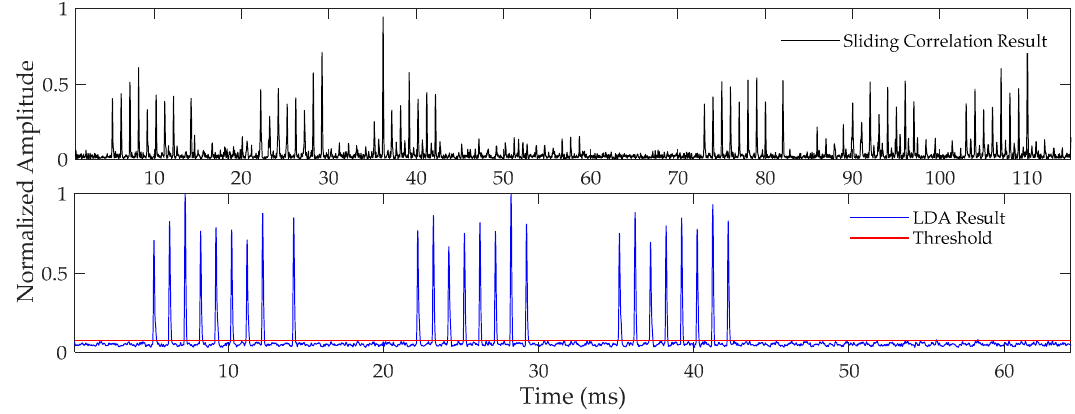
Figure 10. Correlation result and linear digital averaging (LDA) result.